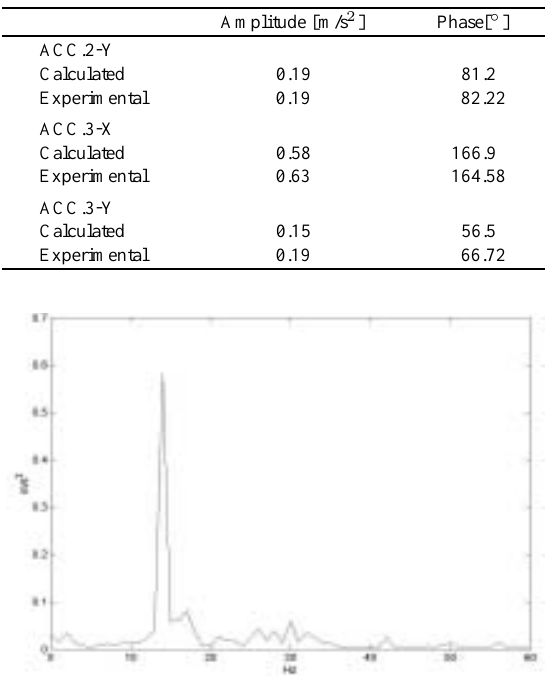
Fig. 8. Amplitude spectrum of acceleration in the X direction measured by accelerometer 1 (m/s 2